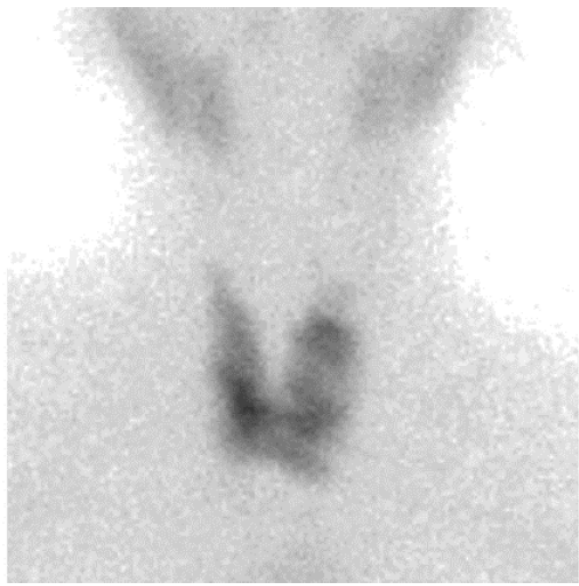
Figure 3. Thyroid scintigraphy with TC-99 74 MBq iv: Glandular parenchyma of the thyroid is not homogeneous, due to the presence of various hypocaptic areas in the context of both lobes, of which the two largest were located one in the right upper lobe and the other in the middle third and at the base of the left lobe.